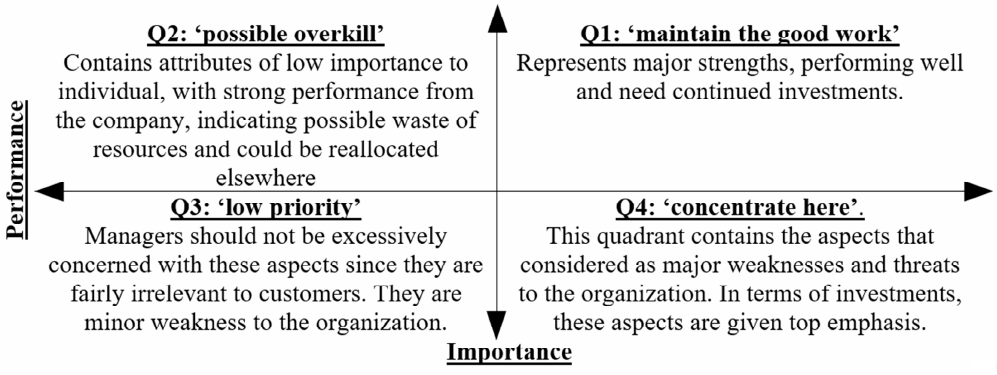
Figure 1. The quadrants in the standard IPA plot.